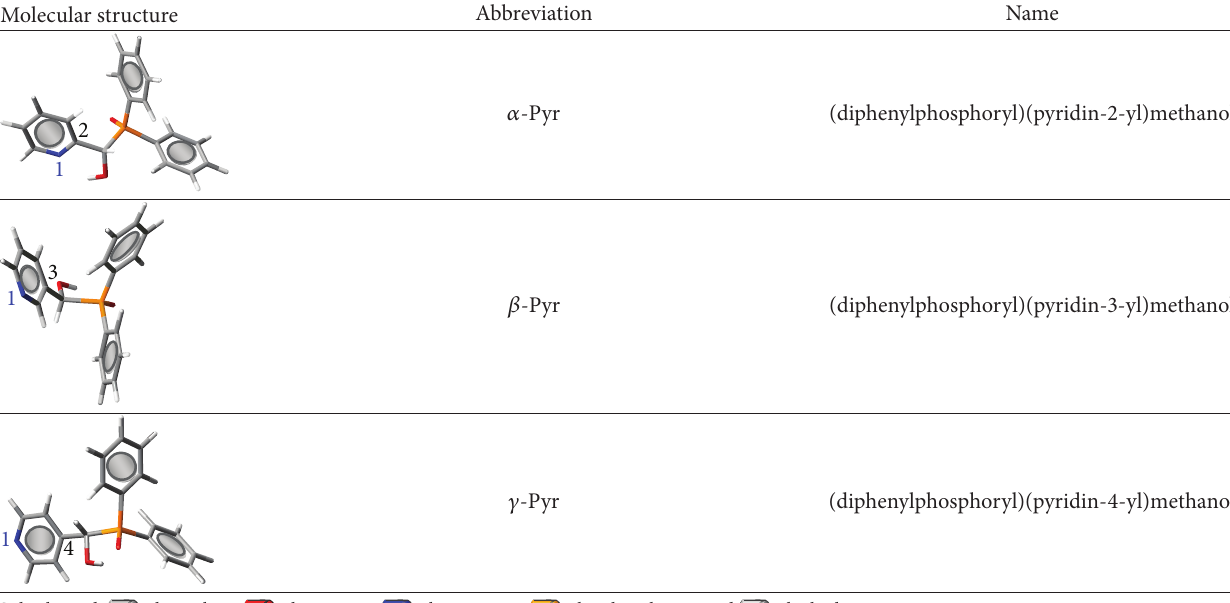
Table 1: Molecular structures of the investigated